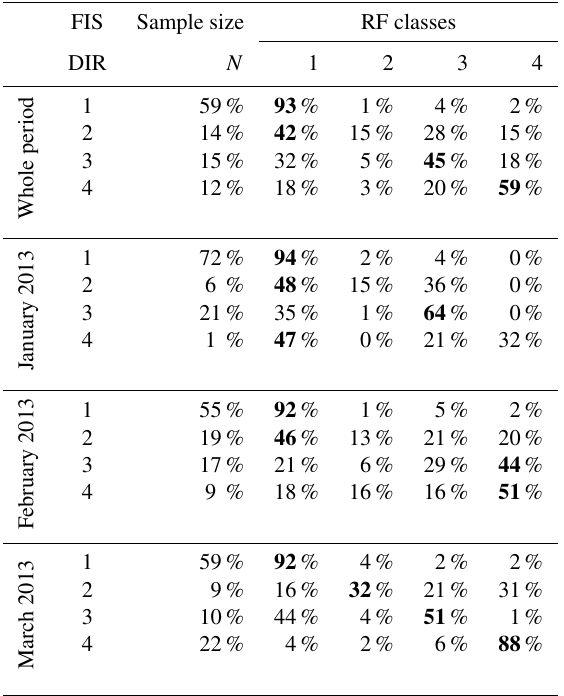
Table 3. Confusion matrix for all ridged-ice categories in the RF classification. The largest estimated DIR category for each refer- ence category is marked in